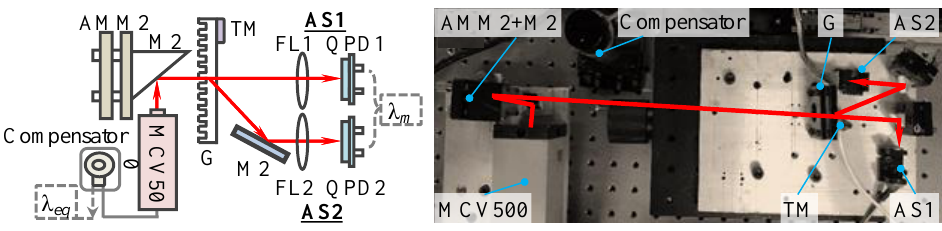
Figure 5. Experimental setup for investigating the performance of the RWC.